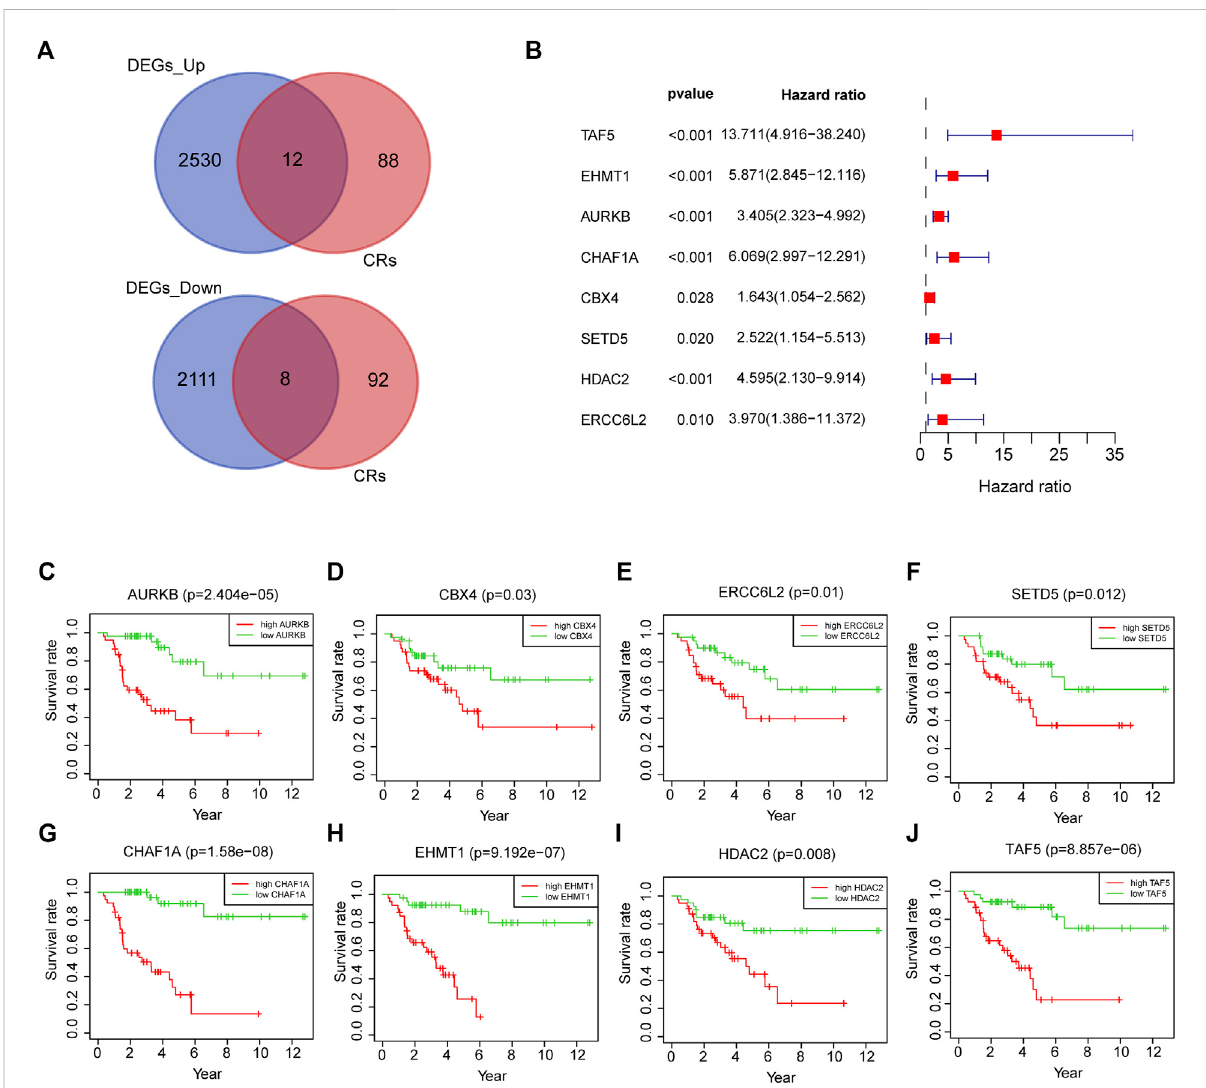
FIGURE 1 20DECRsselectedfromtheintersectionofDEGsandCRs (A) .UnivariateCoxregressionofeightDECRsthatshowedaprognosticvalue (B) .KM survival analysis of eight DECRs that showed a prognostic value (C – J)